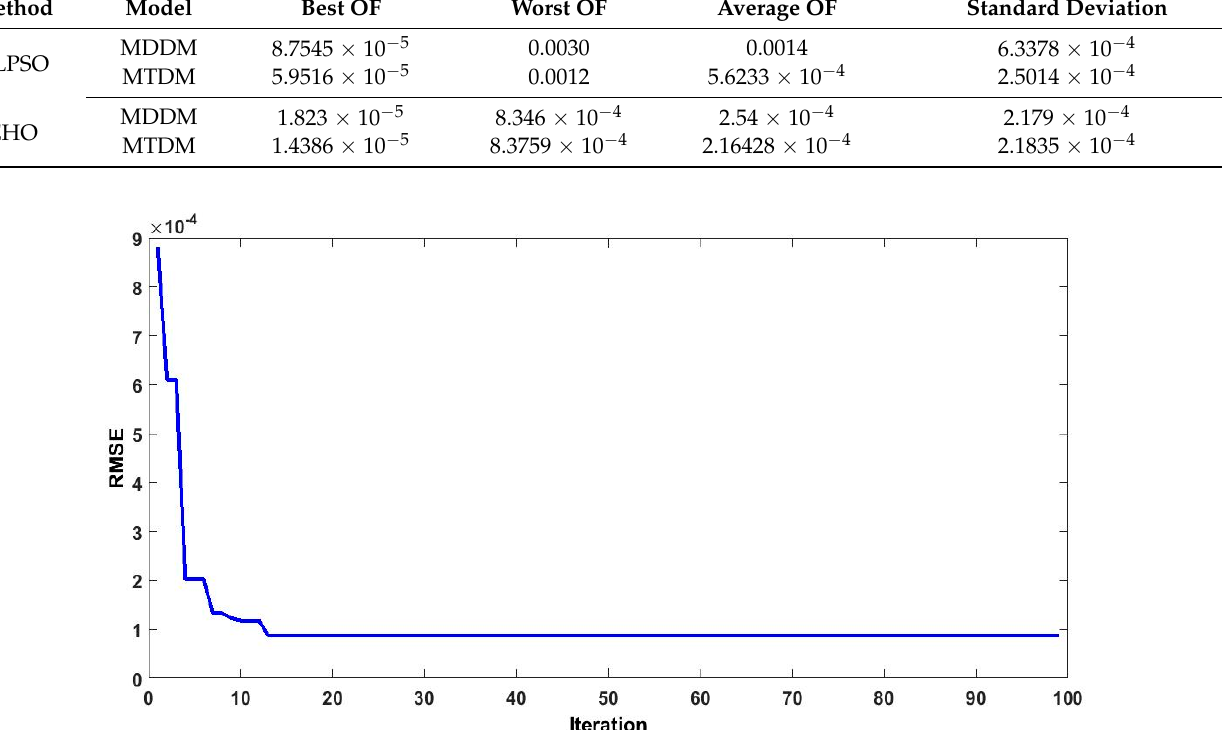
Figure 3. Convergence rate for the MDDM using CLPSO.